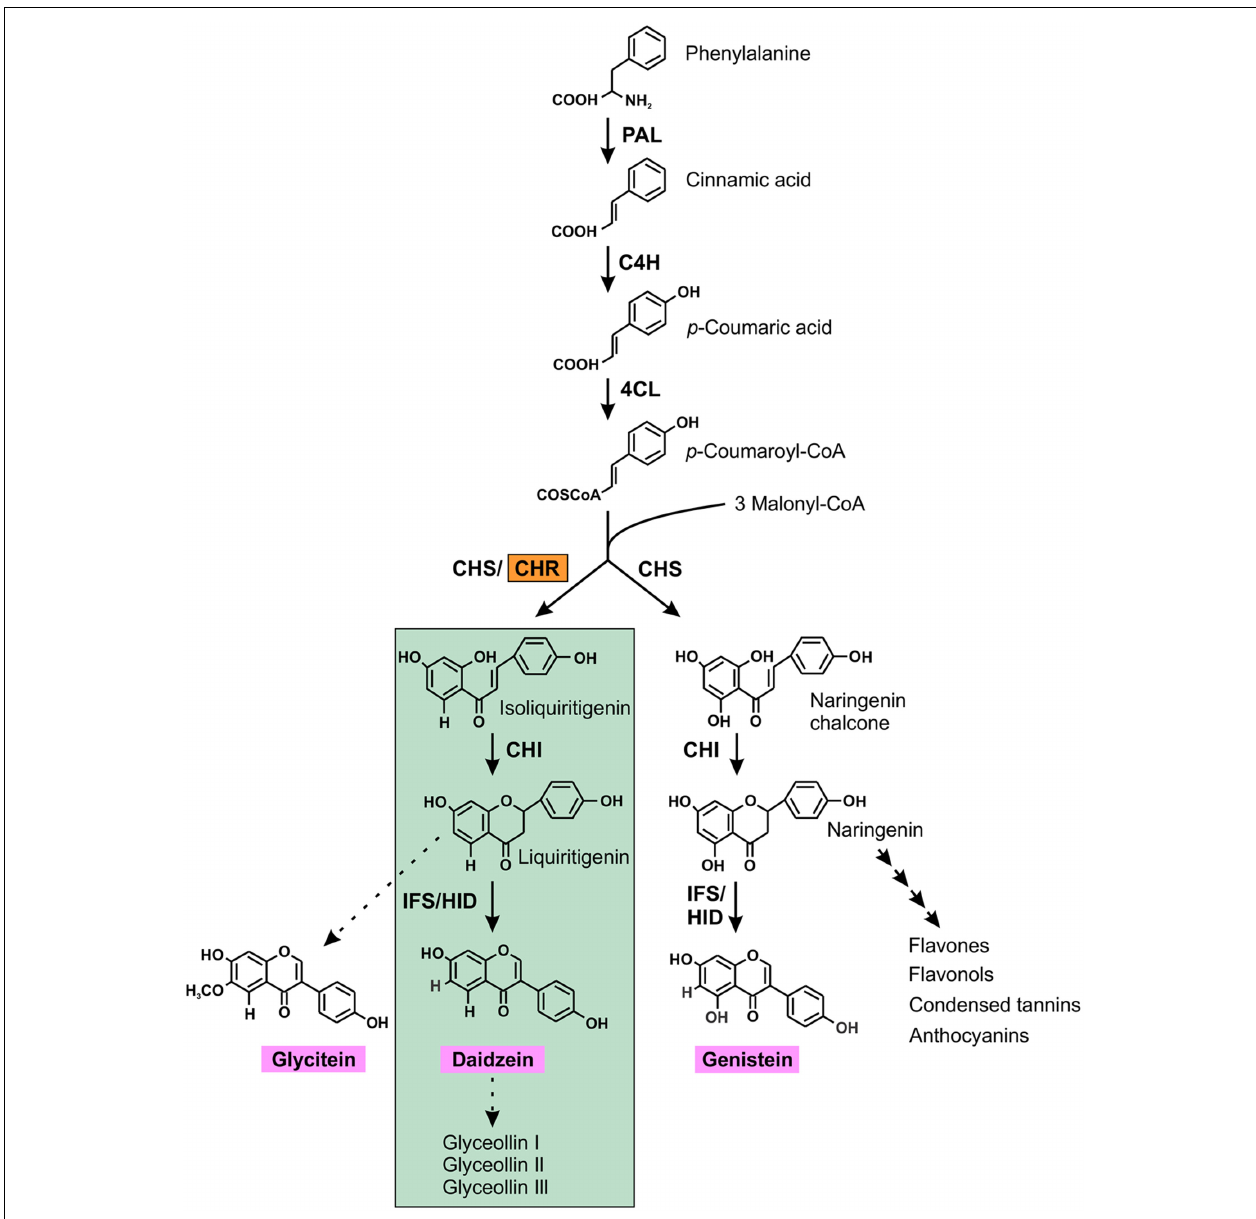
FIGURE 1 | (Iso) flavonoid biosynthetic pathway in soybean. The first key legume-specific enzyme chalcone reductase (CHR) is highlighted in orange that leads into the synthesis of isoflavonoid phytoalexins (green highlights) in soybean. The three isoflavone aglycones glycitein, daidzein and genistein are shown in pink. The dotted arrow indicates speculative steps while multiple arrows indicate two or more steps in the pathway. PAL, phenylalanine ammonia lyase; C4H, cinnamate 4-hydroxylase; 4CL, 4-coumarate:CoA ligase; CHR, chalcone reductase; CHS, chalcone synthase; CHI, chalcone isomerase; IFS, isoflavone synthase; 2HID, 2-hydroxyisoflavanone